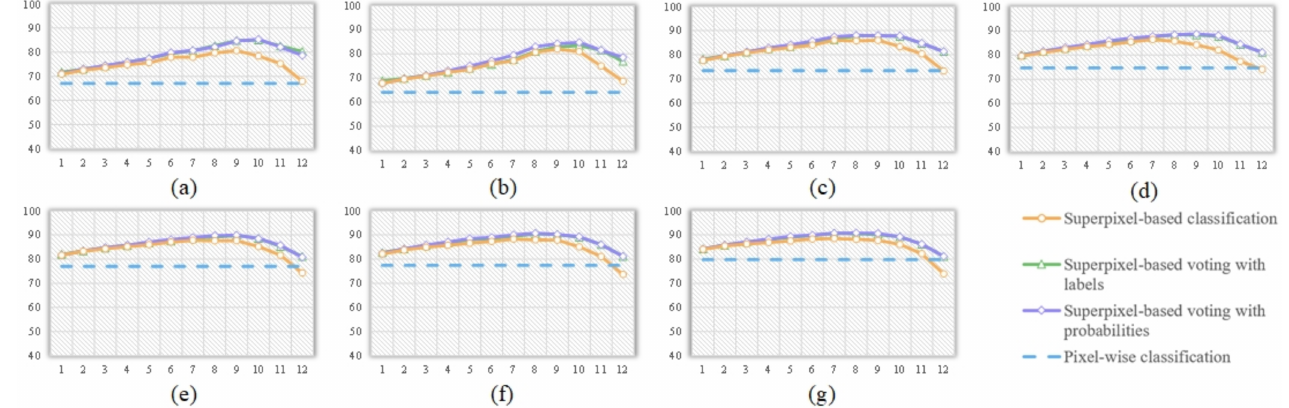
Figure 7. Accuracies given by the single-scale approaches with ( a ) 25, ( b ) 50, ( c ) 100, ( d ) 150, ( e ) 200, ( f ) 250, and ( g ) 300 training samples per class for the Honghu dataset using SVM, where the vertical axis represents the OAs, and the horizontal axis represents the superpixel segmentation scale.